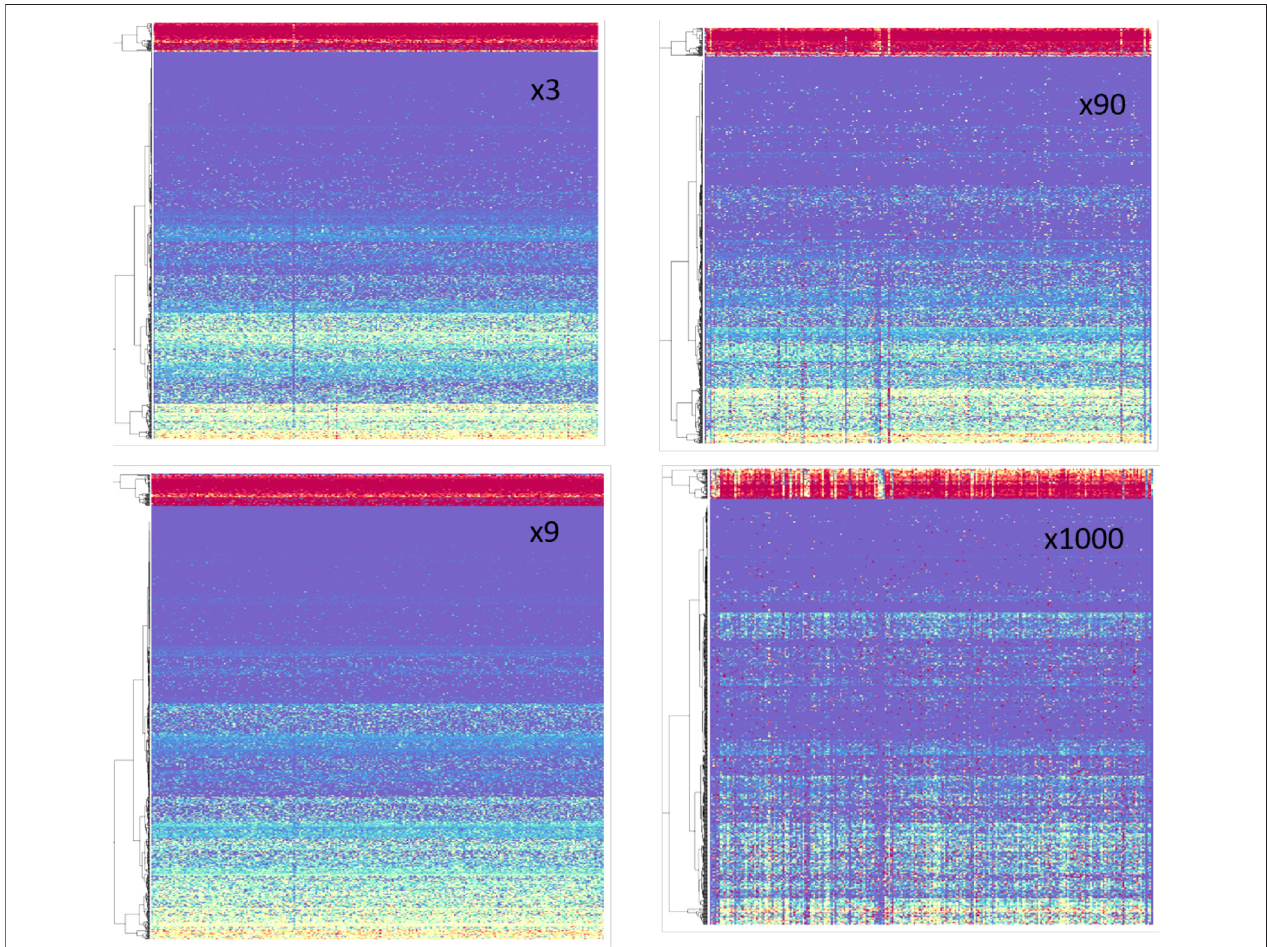
FIGURE 5 | Retention values following in silico overexpression from HeLa cells. Rainbow color code: red (cid:1) 0 to purple (cid:1) 100% retention level at the end of the simulationrun(100 kiterations).Each panel consists of248miRNAs (columns)and 750genes(rows). Theoverexpressionfactors areindicated(x3x9,x90,x1000). The miRNAs (columns) are sorted alphabetically, matrices are clustered by